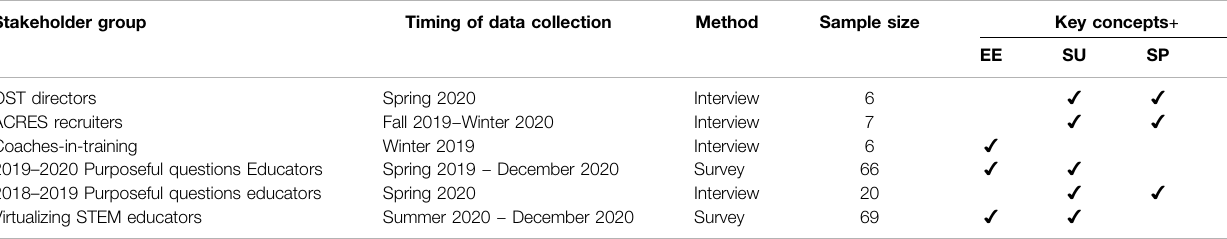
TABLE 3 | Summary of study methods, by stakeholder